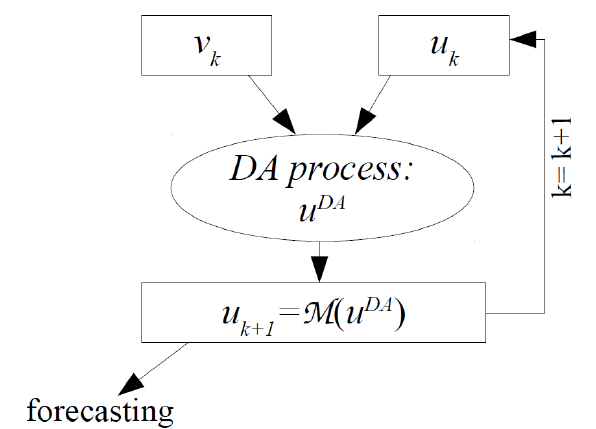
Figure 1. The prediction-correction